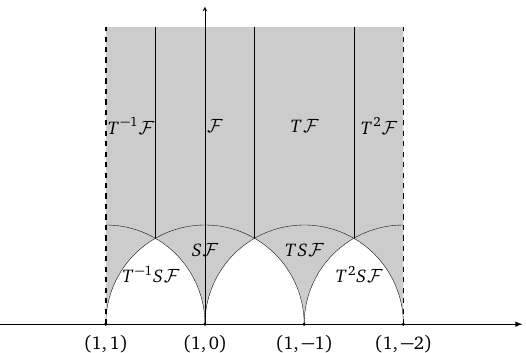
= 1 theory, with the f 1